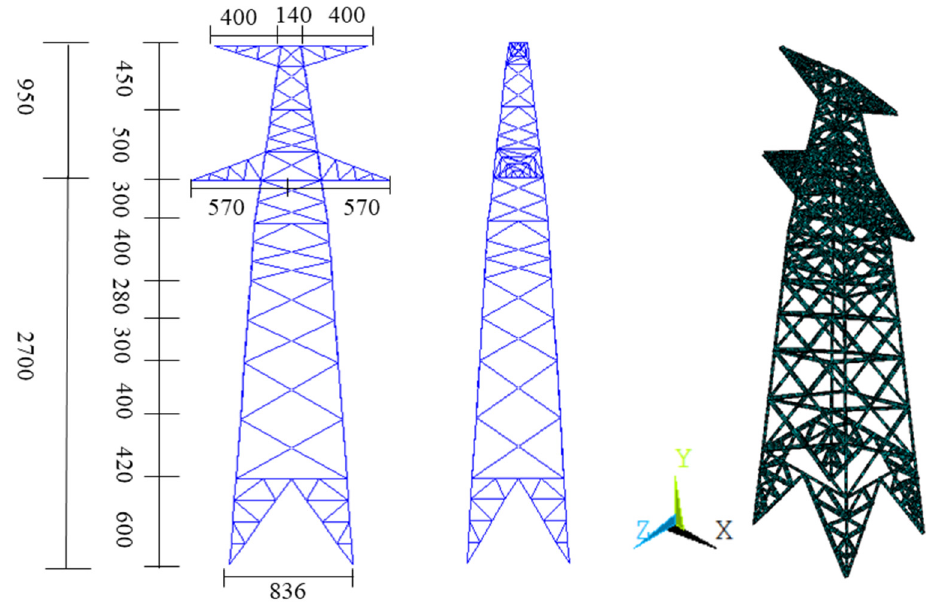
Figure 1. The finite element model of the transmission tower structure (the unit is cm, serial number [19] for the transmission tower is 2A2-J1).